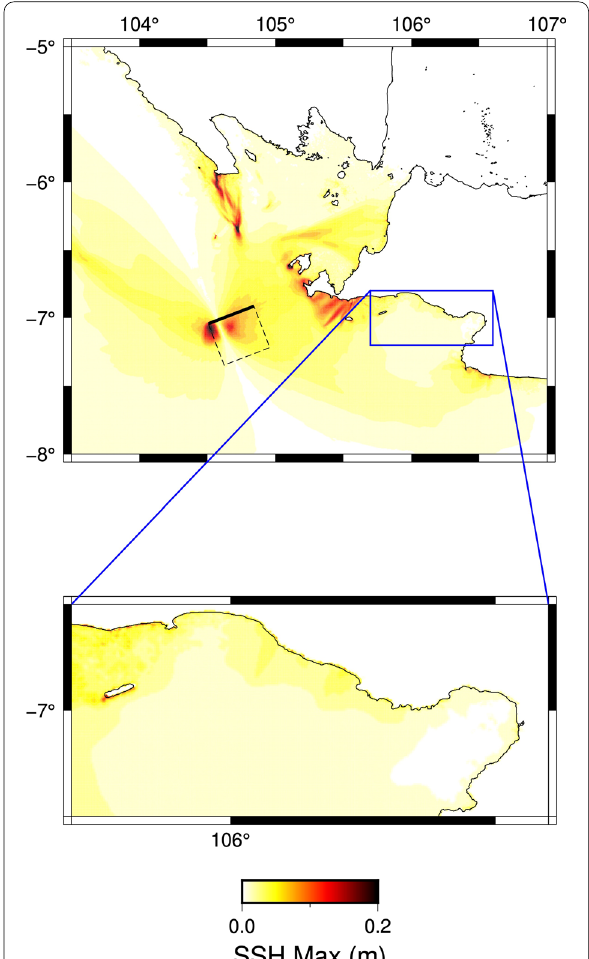
Fig. 5 The sea surface height maximum during simulation running for 2 h for a fault Model 1A